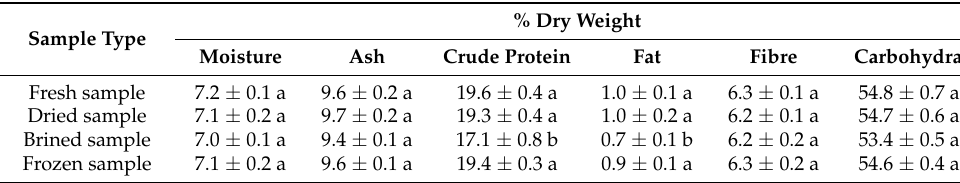
Table 1. Proximate composition on a dry basis (% dry weight) of different tropical black bolete